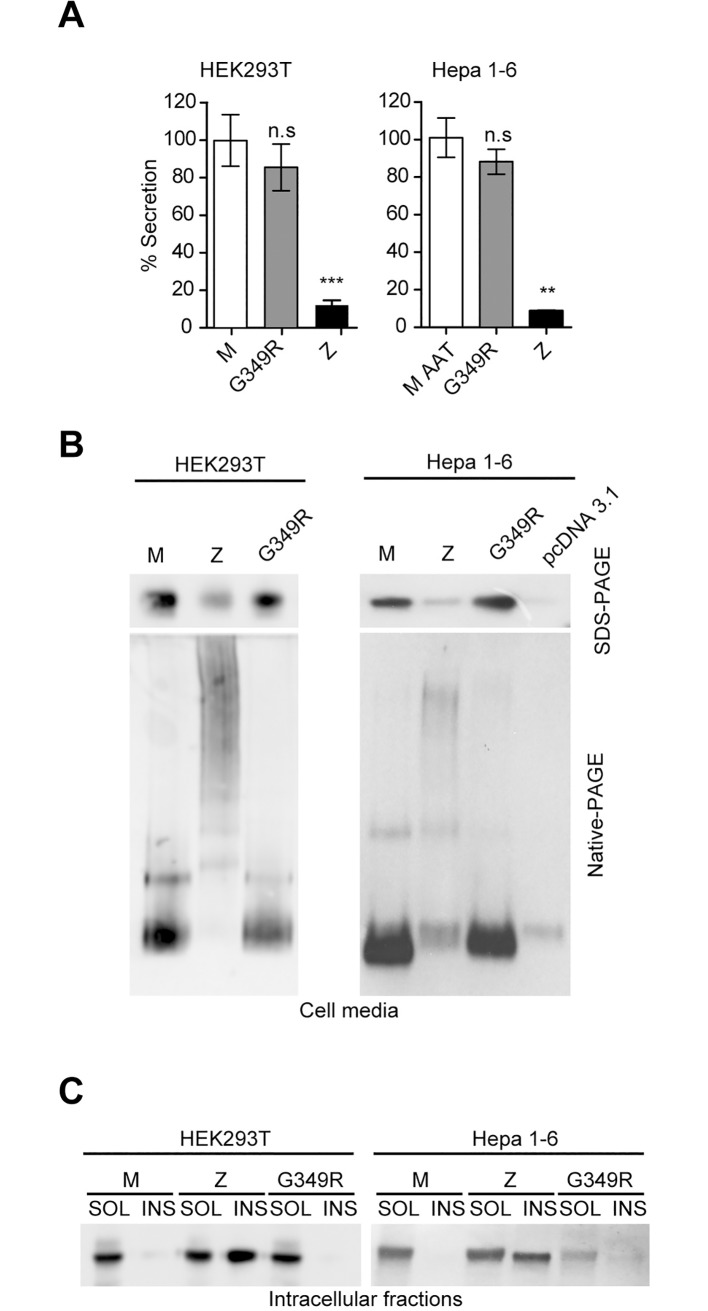
Characterization of the G349R variant in cell models.(A) AAT levels in cell media from transfected HEK293T or Hepa 1–6 cells were quantified by sandwich ELISA and represented as percentages of wild-type M levels (mean ± SD, n = 3; one-way ANOVA, p < 0.0001; two-tailed unpaired t-test between each variant and M AAT, n.s non-statistically significant, **p < 0.001, ***p < 0.0001). (B) Immunoblots with anti-total AAT pAb loaded with equal volume of cell media from HEK293T (left) or Hepa 1–6 (right) cells expressing the indicated variants, resolved by 7.5% w/v acrylamide SDS-PAGE (top) and 8% Native-PAGE (bottom). (C) Immunoblots with anti-total AAT pAb of NP40-soluble (SOL) or insoluble (INS) cellular fractions from HEK293T (left) or Hepa 1–6 (right) cells expressing the indicated variants, resolved by 7.5% SDS-PAGE.